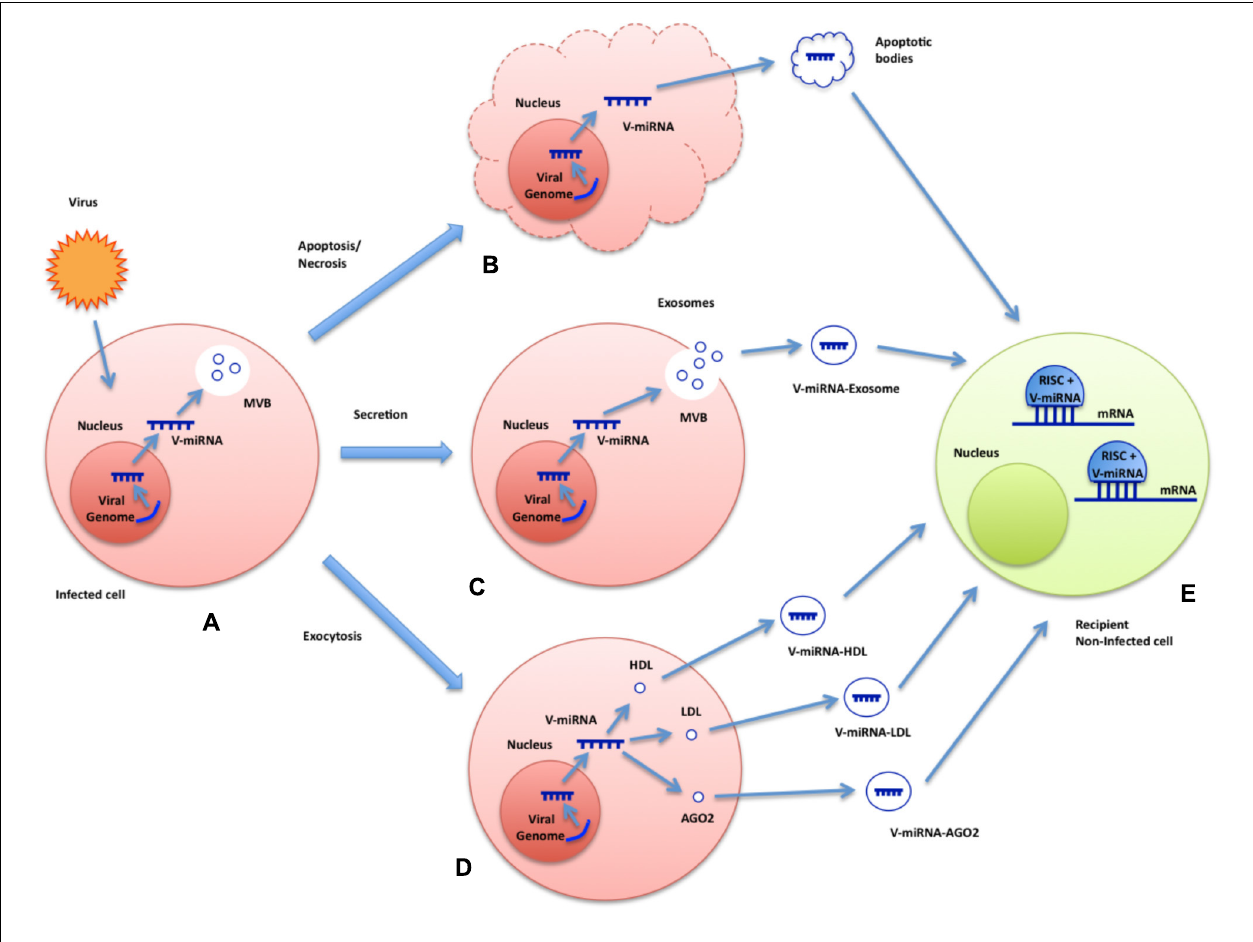
extracellular space and, eventually, be delivered to recipient non-infected cells: inside apoptotic bodies after cell death (B) , packaged into exosomes (C) , or HDL/LDL molecules or even bound to AGO2 (D) .Viral miRNAs may be uptaken by non-infected cells where they could exert their regulatory functions (E)